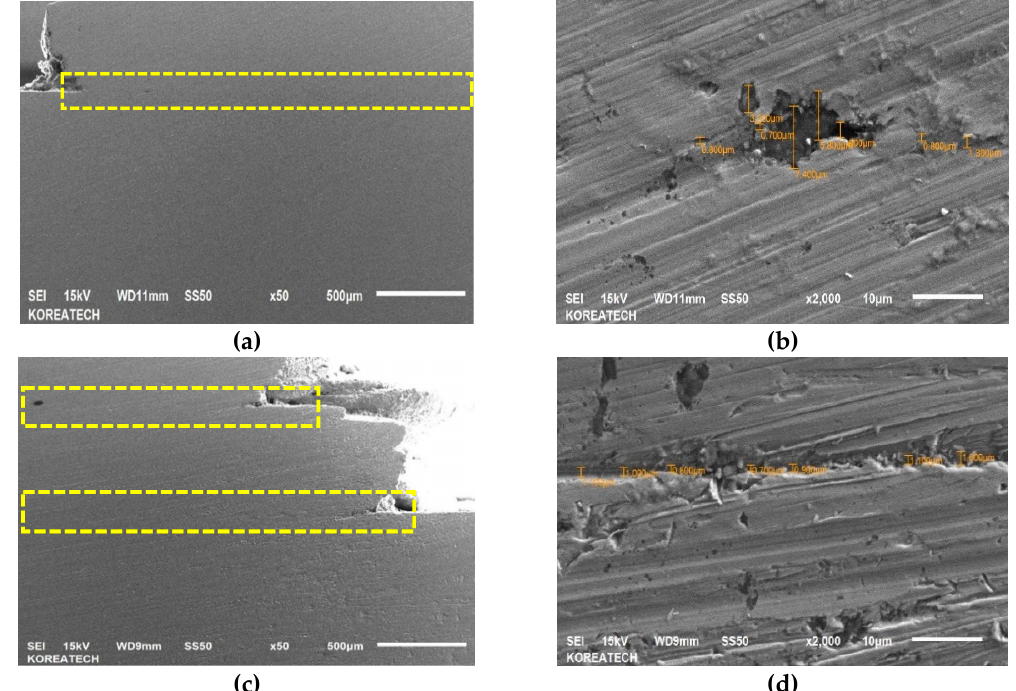
Figure 4. Cross-sectional SEM images of the single ( a , b ) and double ( c , d ) layers.